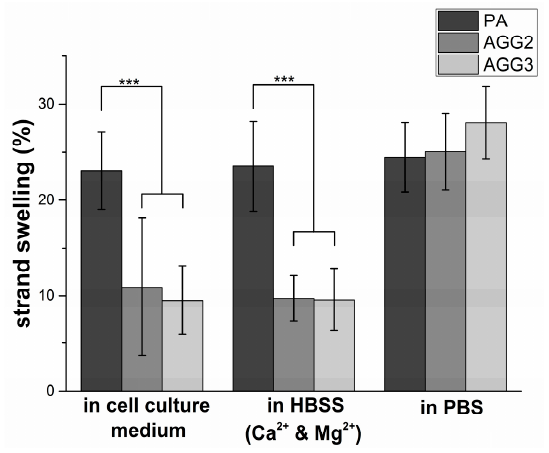
Figure 5. Strand swelling calculated by measuring the strand diameters before and after incubation of freshly crosslinked scaffolds in the respective solutions. (mean ˘ SD; n = 20; *** p <